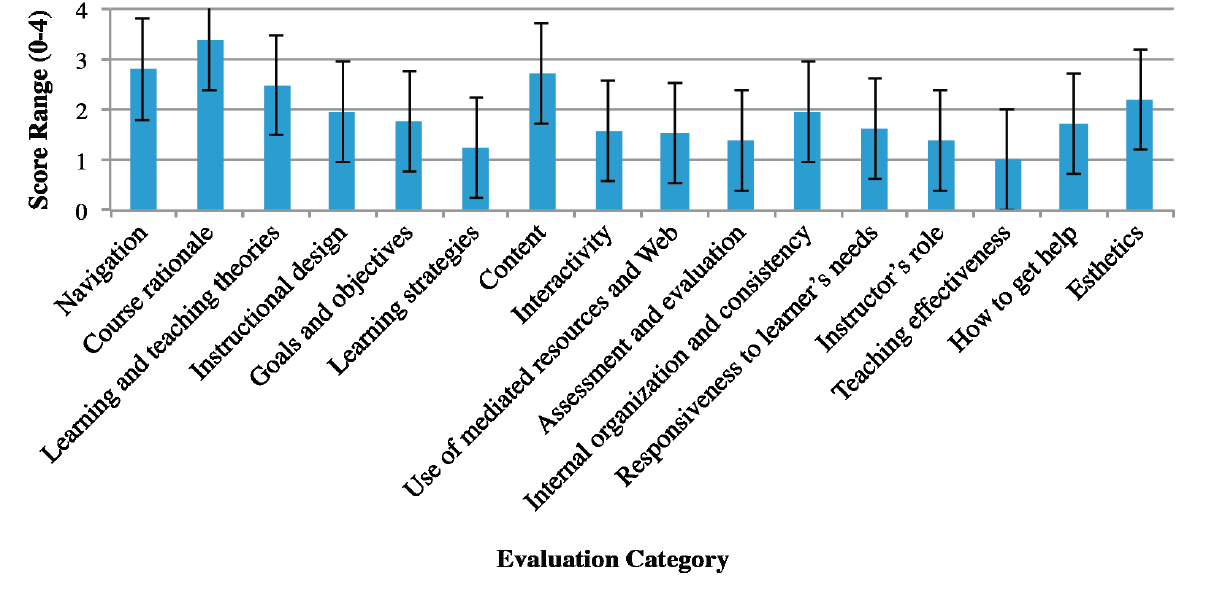
Figure 3. Mean category scores for 24 courses based on the 16 categories evaluated. Error bars indicate standard